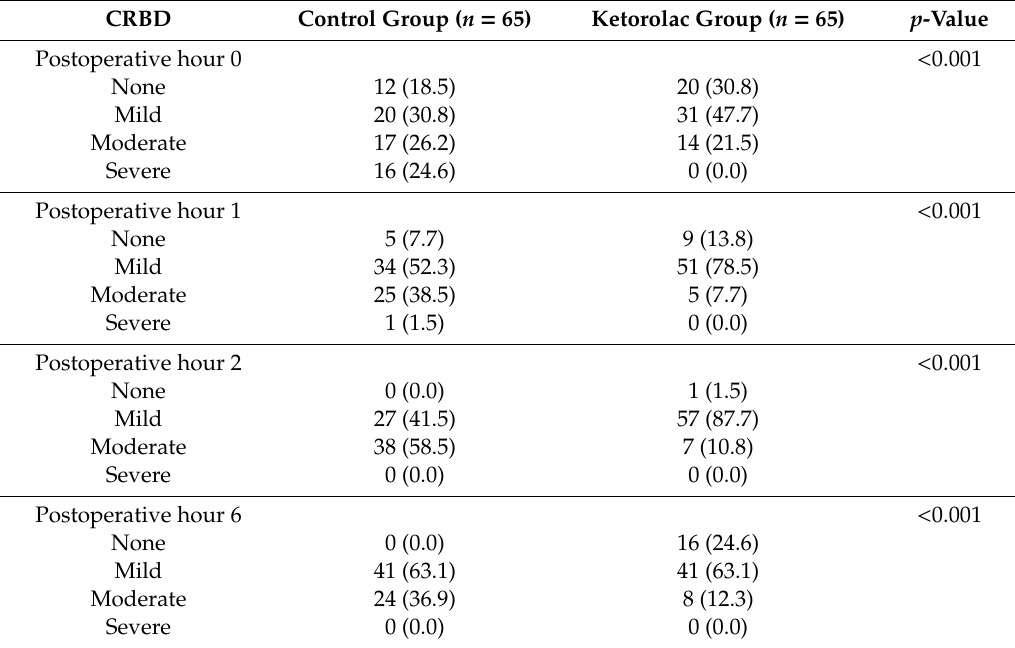
Table 2. Postoperative CRBD in patients undergoing robot-assisted laparoscopic radical prostatectomy.